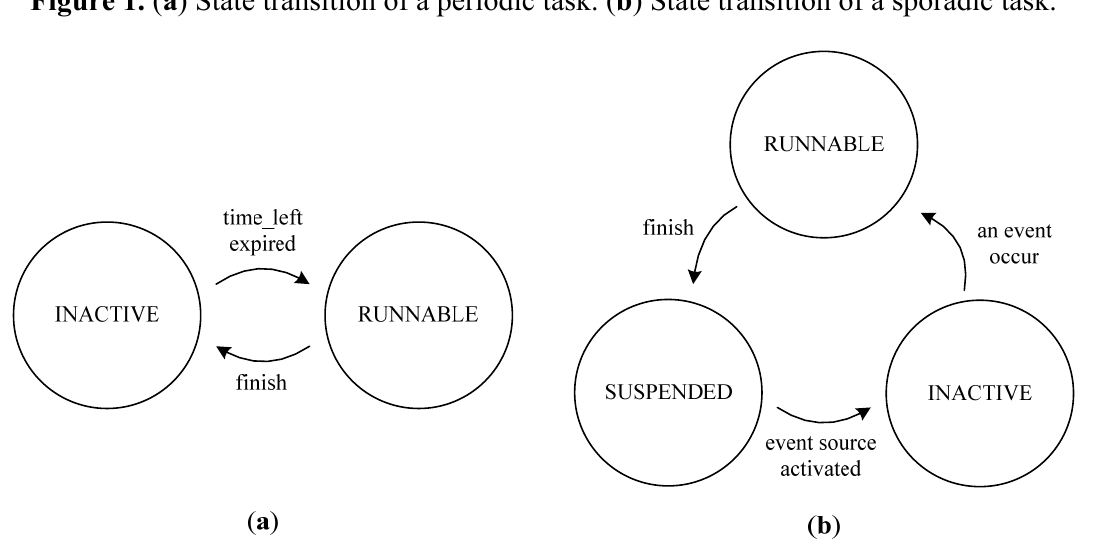
Figure 1. ( a ) State transition of a periodic task. ( b ) State transition of a sporadic